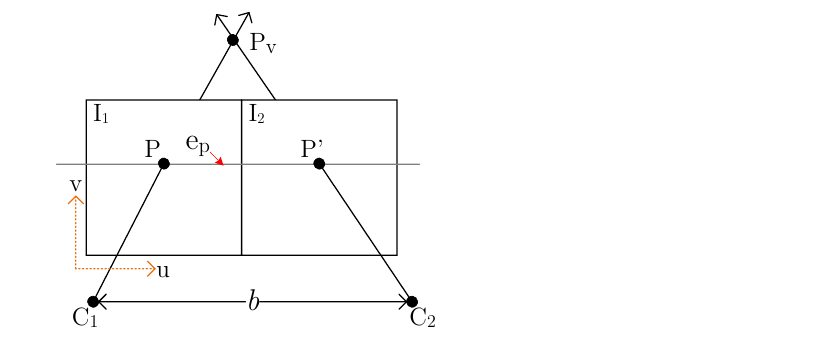
Figure 7. Two parallel micro-images depicting the epipolar geometry of the stereo pair. For each micro-image pair, stereo-matching is performed, the respective error is then subsequently compared. It results in a best-match for the given P ri ( x , y ) . The modified algorithm uses Hamming distance as the cost function to determine the error of similarity during the process of finding the correspondence. Along with the computation of best-match, respective disparity is computed. Finally, in depth-evaluation , virtual depth is estimated by using corresponding disparity and baseline distance of the best-match